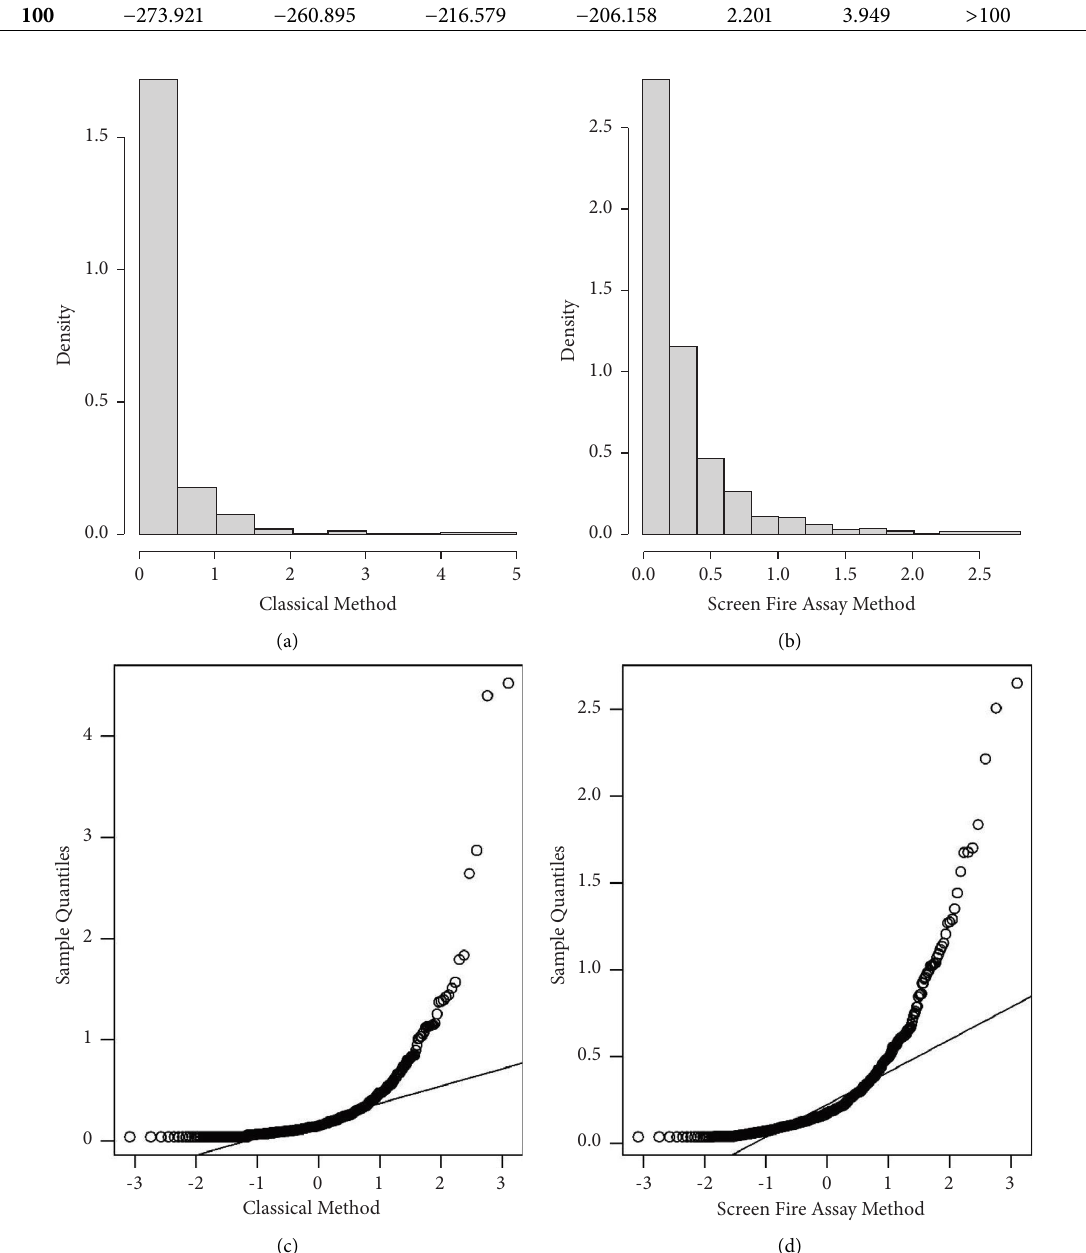
Figure 1: Histogram (a, b) and normal Q-Q plot (c, d) of the gold particle data taken by two measurement methods using the Classical method and the Screen Fire Assay